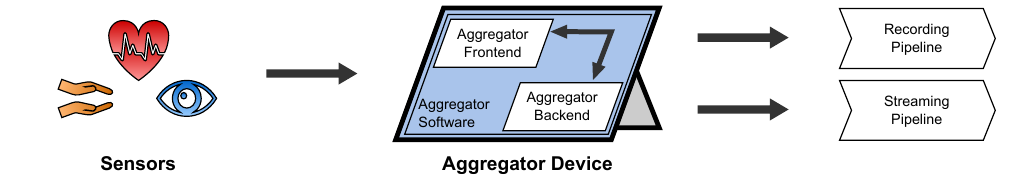
Figure 3. Overview of the Aggregator